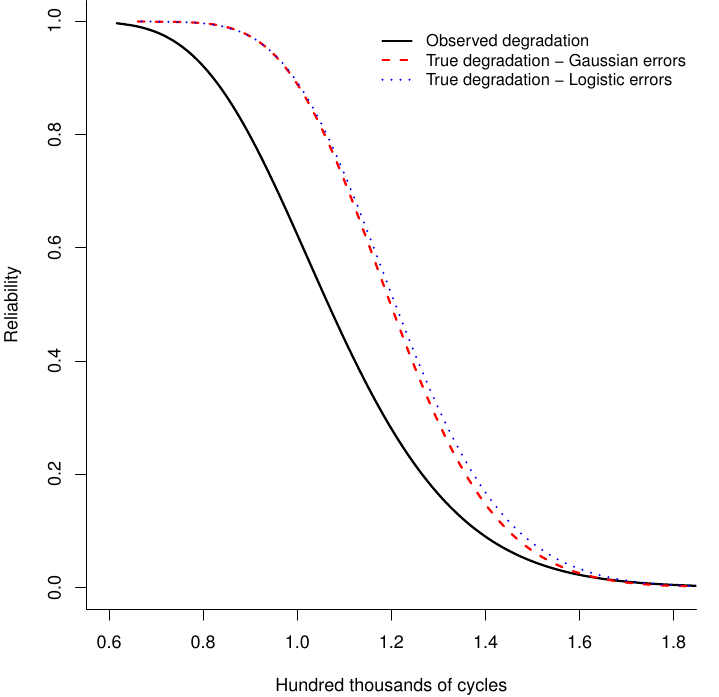
Figure 9. Comparison of reliability functions for the observed degradation and the true degradation under Gaussian and logistic measurement